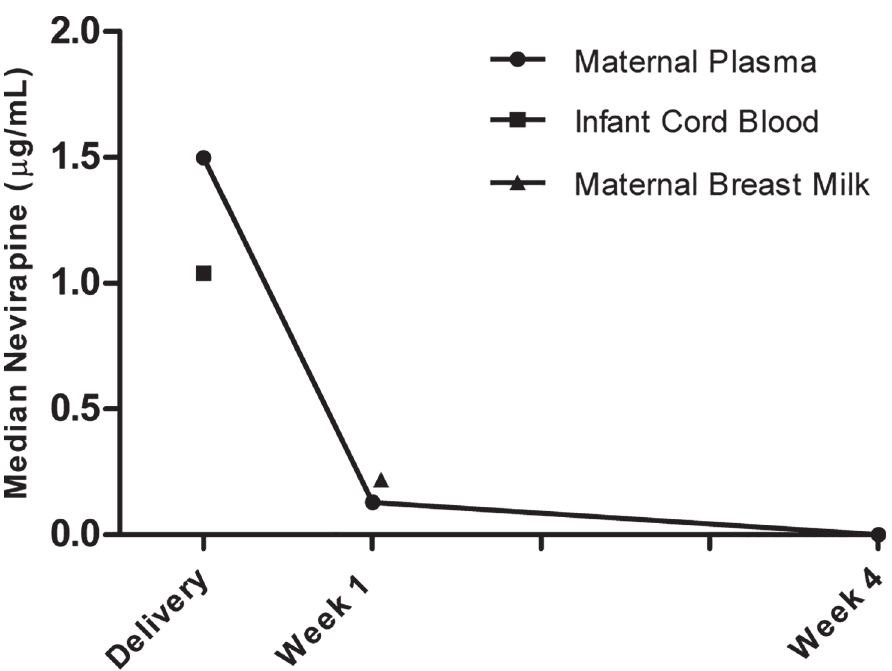
Fig 2. Nevirapine Concentration in Infant Cord Blood and Maternal Plasma and Breast Milk from 273 HIV-Infected Women and their Infants. The medians at delivery are based on 223 maternal plasma samples and 165 infant cord blood samples. The medians at 1 week postpartum are based on 228 maternal plasma samples and 205 breast milk samples. The median at 4 weeks postpartum is based on 42 maternal plasma samples.